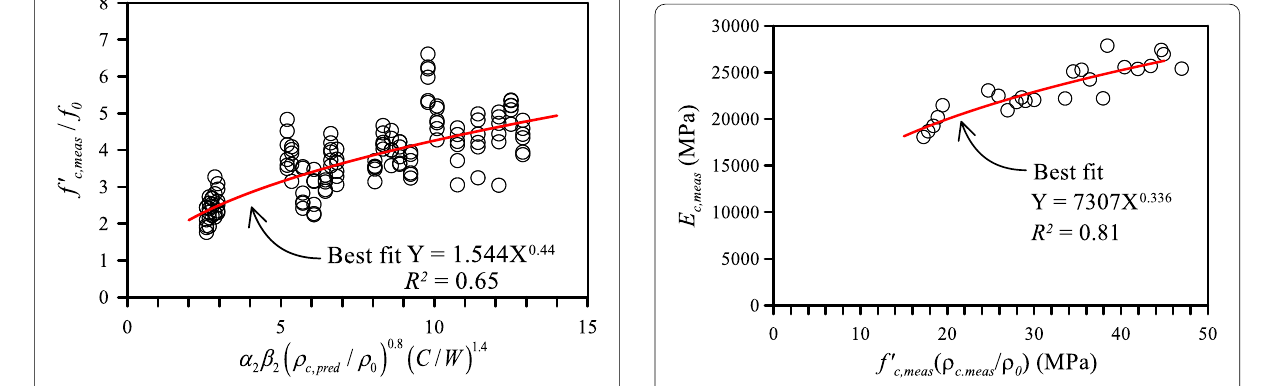
Fig. 3 Regression analysis for f’ c,meas .